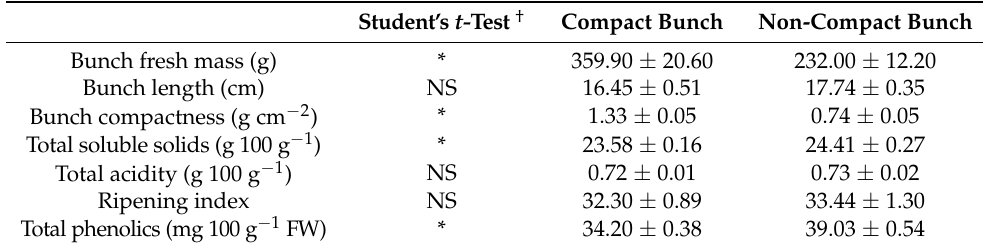
Table 1. Effects of bunch compactness on parameters related to bunch architecture and berry chemical quality at harvest in the 2018 growing season.